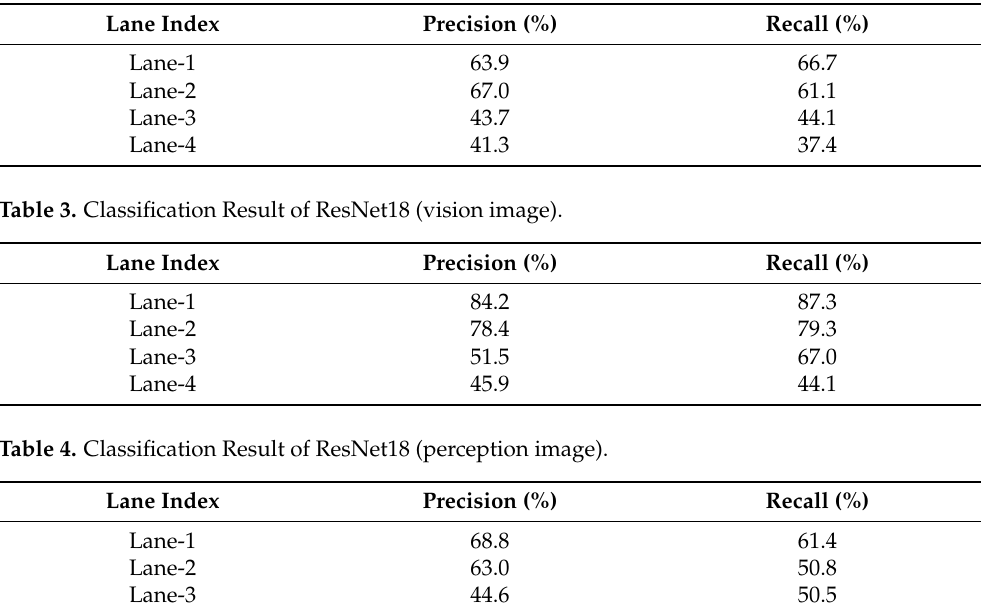
Table 2. Classification Result of Vgg16 (vision image).